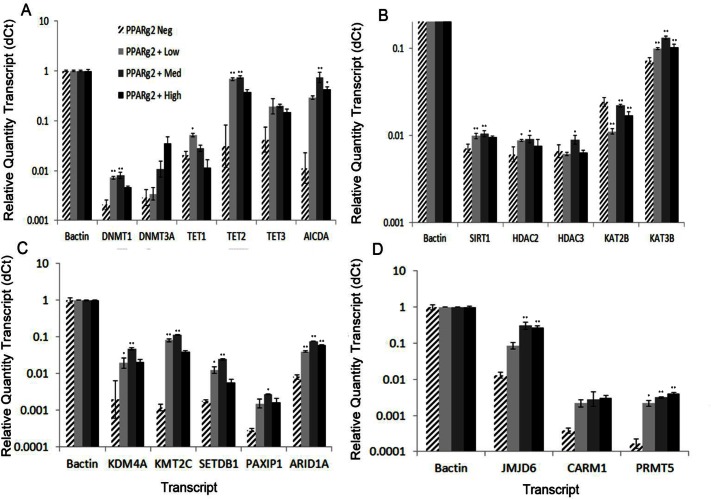
Transcript profiles for factors controlling chromatin modification.Relative quantities of marker transcripts among the four classes of VAT cell nuclei isolated by FANS were determined by qRT-PCR. A. Factors controlling the levels of 5-methylcytosine modification of DNA (DNA cytosine methyltransferases DNMT1 and DNMT3A, methylcytosine dioxygenases (TET1, TET2, TET3), and activation-induced cytidine deaminase (AICDA)). B. Factors controlling acetylation of nucleosomal histones (deacetylases Sirt1, HDAC2, and HDAC3 and histone lysine transacetylases KAT2B and KAT3B). C. Factors involved in histone lysine methylation (ARID1A/BAF250, MLL3, and PAXIP1/PTIP impact histone H3 methylation at lysine 4, and SETDB1 and KDM4A impact histone H3 methylation at lysine 9). D. Factors involved in histone arginine methylation (JMJD6 is histone arginine demethylase and CARM1/PRMT4 and PRMT5 are arginine methyltransferases). See legend to Fig 4 for details of the RQ calculation. A p value of P<0.01 is denoted by asterisk (*) and a p value of P<0.001 is denoted by double asterisk (**).